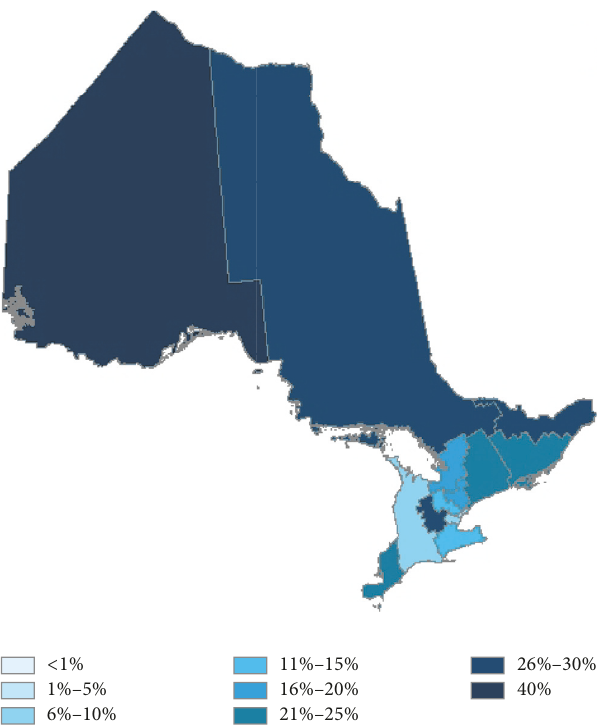
Figure 1: Percent of patients with concurrent disorders receiving psychiatric services via telemedicine.